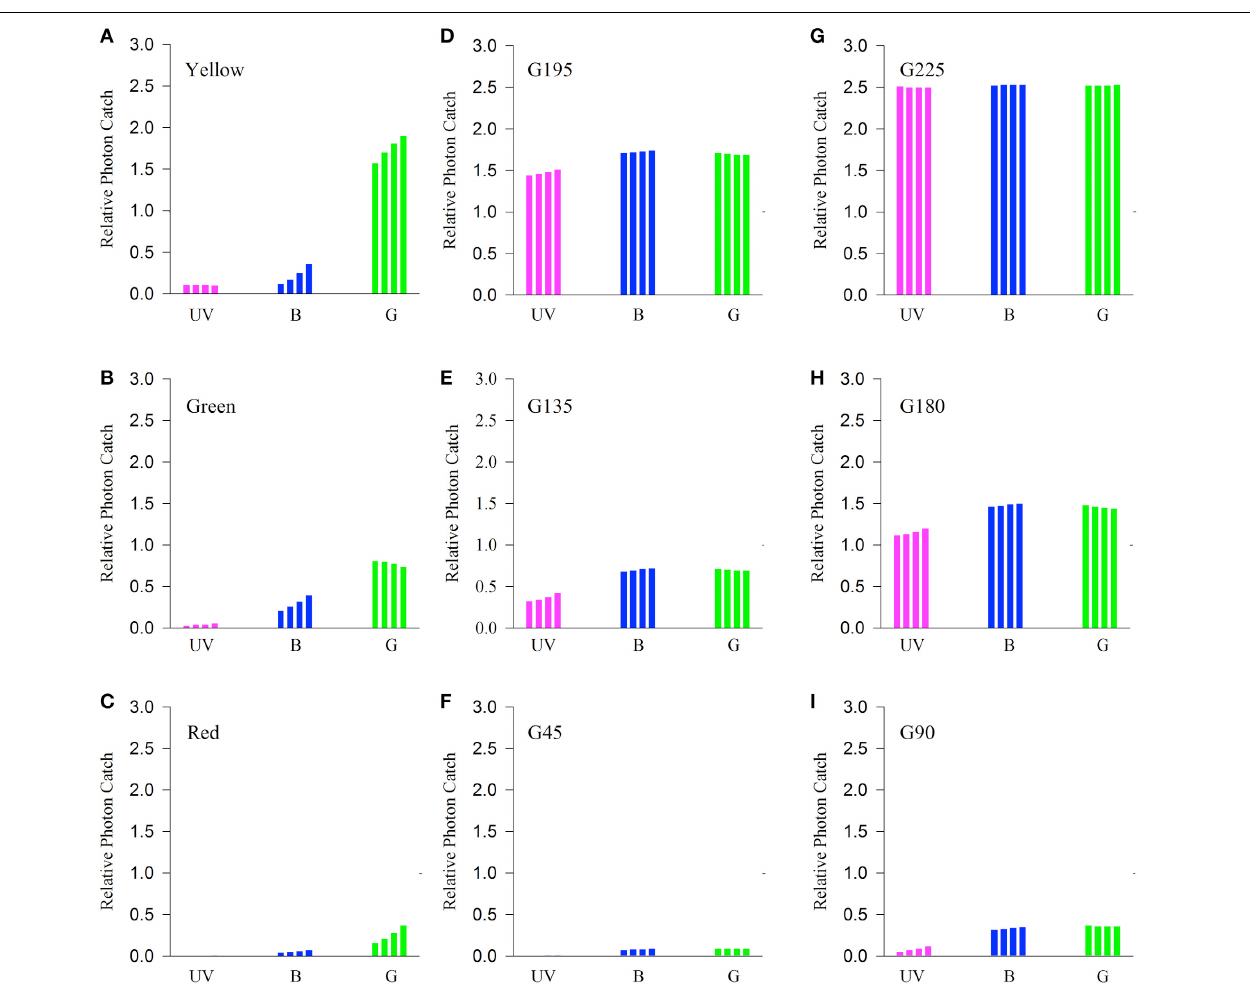
FIGURE 8 | Comparison of the quantity of light caught by putative psyllid photoreceptors. Bars represent relative photon catch of hypothetical photoreceptor sensitivities. Purple bars represent the quantity of light caught by the UV receptor (for α max = 330, 340, 350, and 360nm, successively);